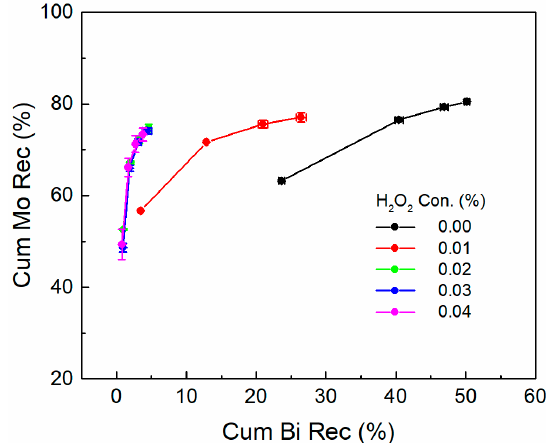
Figure 6. Effect of H 2 O 2 addition on Mo concentrate and its selectivity against bismuthinite. Error bars represent the standard deviation between duplicate tests.